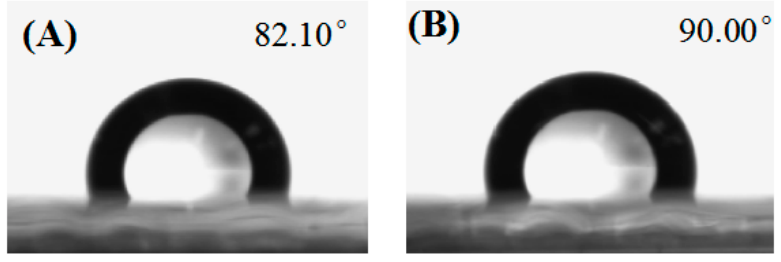
Figure 4. Water droplet contact angles of ( A ) P3HT:IC 60 BA and ( B ) P3HT:IC 60 BA:DHP.